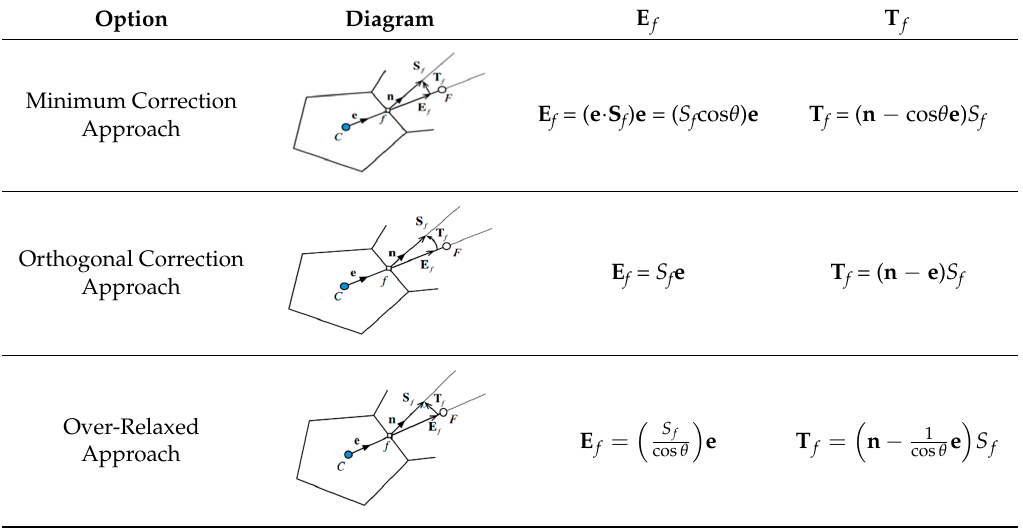
Table 1. Different options for the decomposition of surface vector S f . Table 1 . Different options for the decomposition of surface vector Table 1 . Different options for the decomposition of surface vector Table 1 . Different options for the decomposition of surface vector f S .